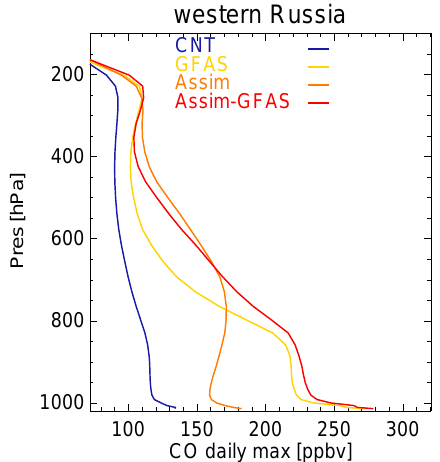
Fig. 8. Averaged daily maximum CO profiles for the four hindcast runs, at D+0 over western Russia, for the time period 20 July–15 August.